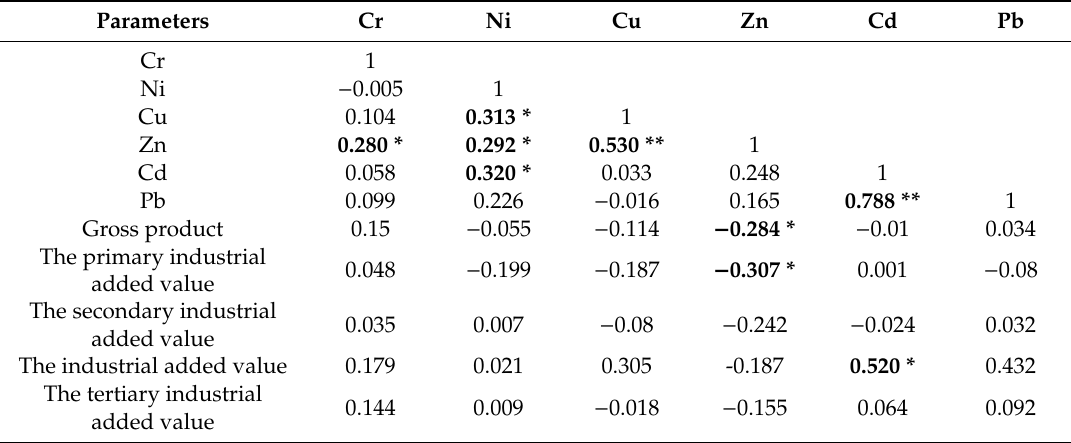
Table 3. The Pearson correlation analysis of heavy metals and economic